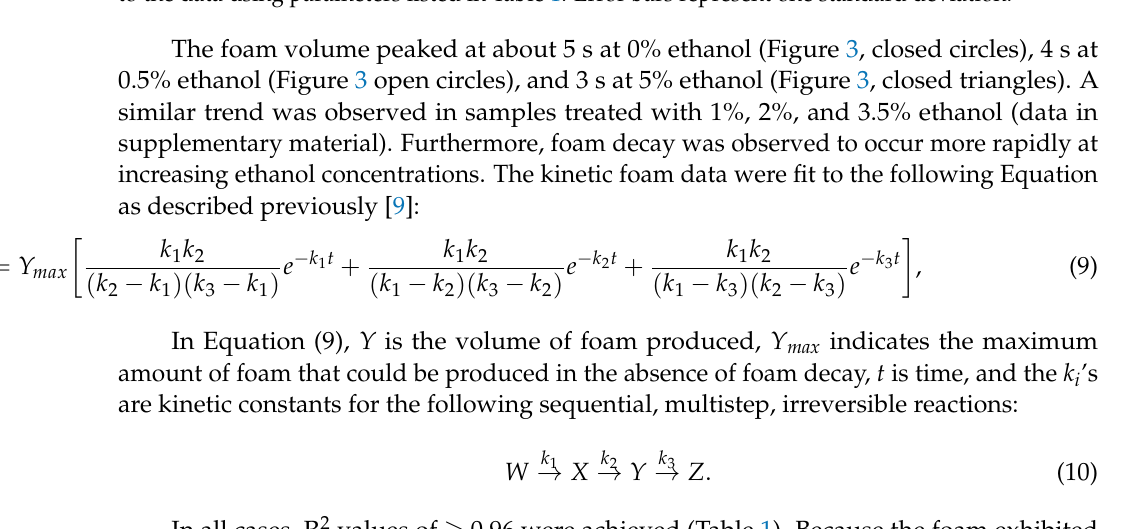
Figure 3. Kinetics of foam production when 1 min Mentos candy is added to 500 mL of Diet Coke at 20–21 ◦ C as described in the text. ( Closed circles ) Control samples to which water was added; ( open circles ) samples to which 0.5 %; and ( X’s ) 5% ethanol by mass was added. Lines represent fits to the data using parameters listed in Table 1. Error bars represent one standard